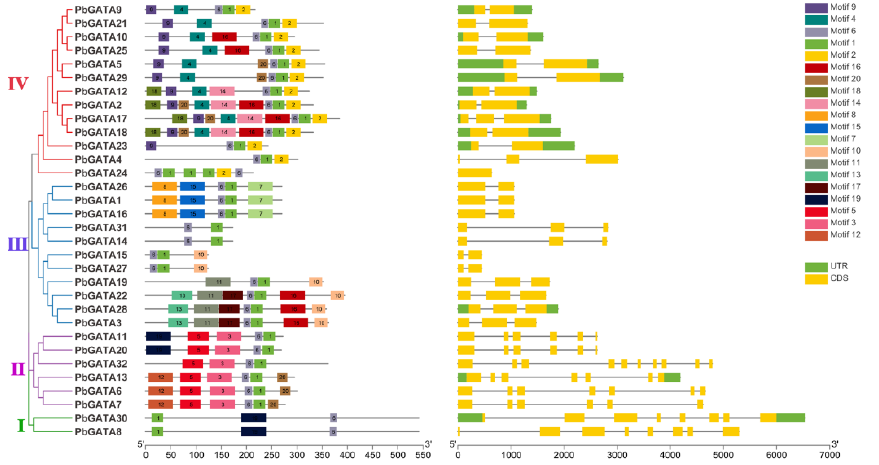
Figure 2. Phylogenetic tree, conserved motif, and gene structure analysis of GATA genes. Phylogenetic relationship ( left ); 20 conserved motifs analysis was performed using MEME (motif-based sequence analysis tool) and each motif is represented with a colored box ( middle ). The introns-exons organization in GATA genes is denoted; yellow boxes represent exons, introns are represented with thin black lines, and the green boxes indicated the untranslated (UTR) region ( right ).